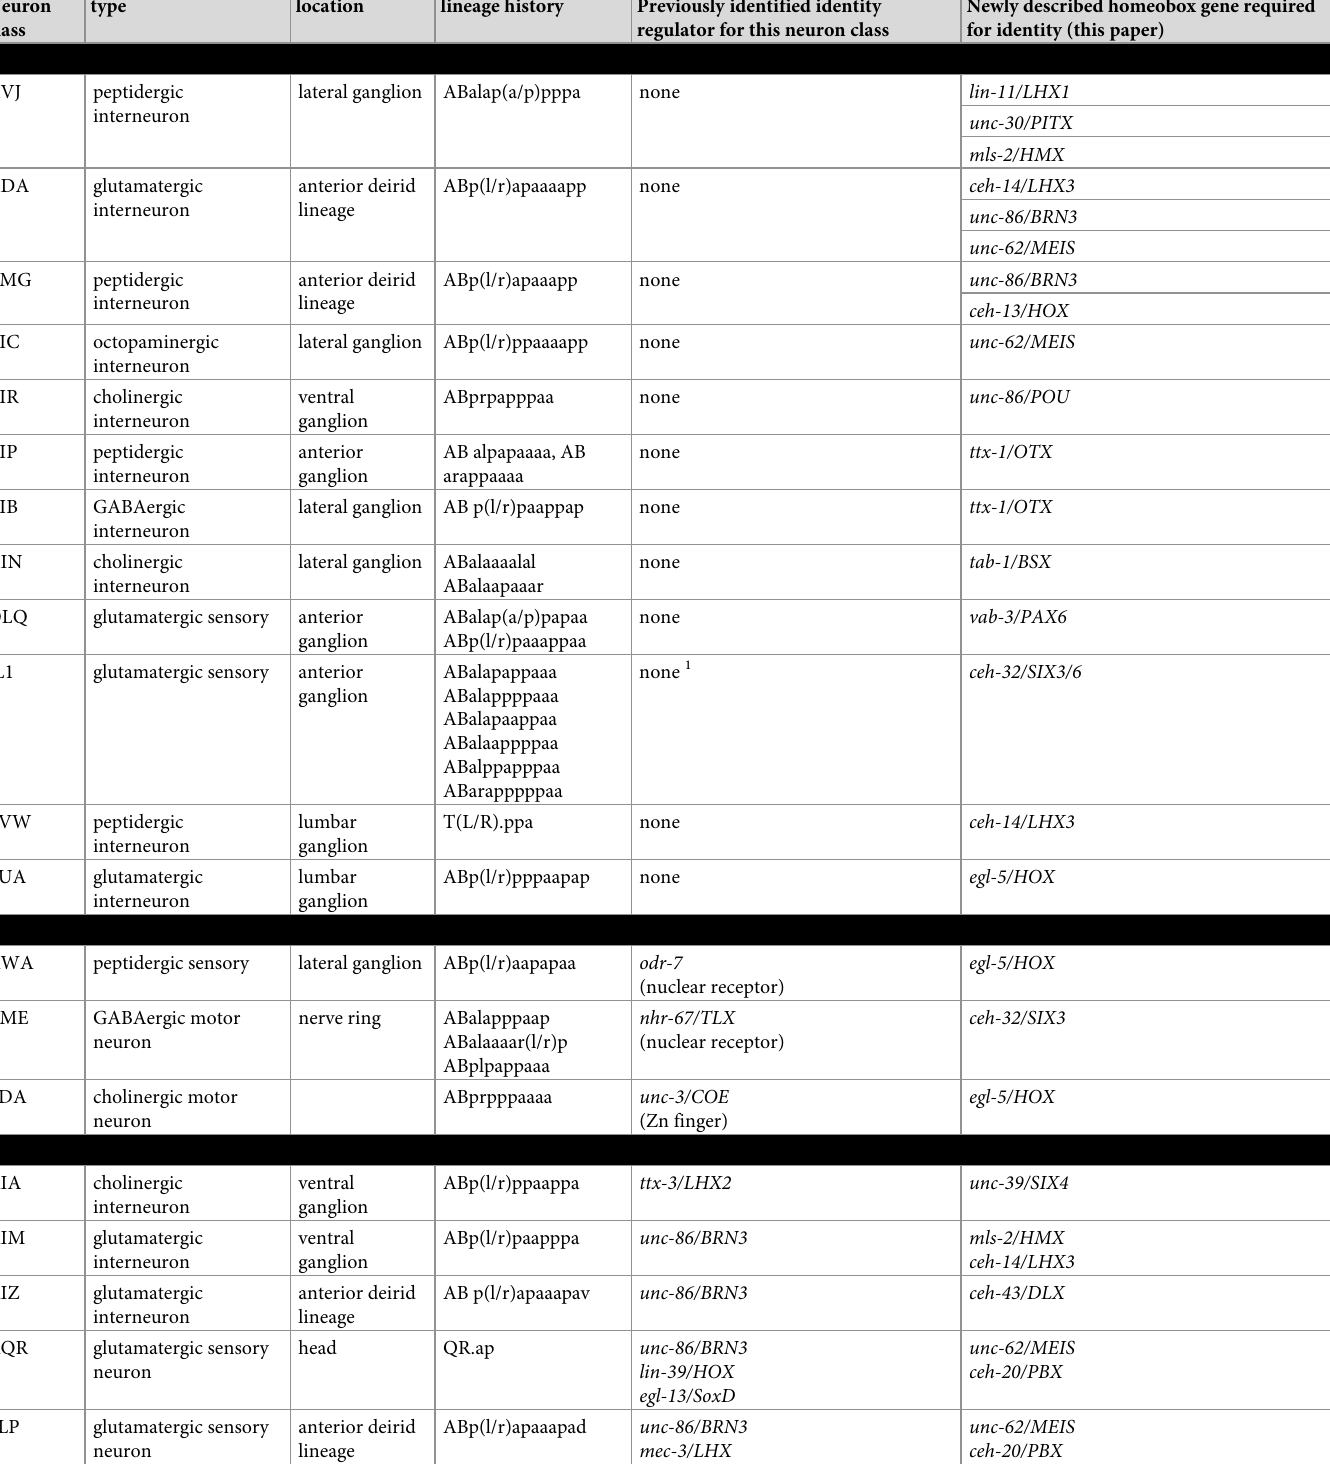
Table 2. Summary of newly identified homeobox regulators of neuronal differentiation. Neuron